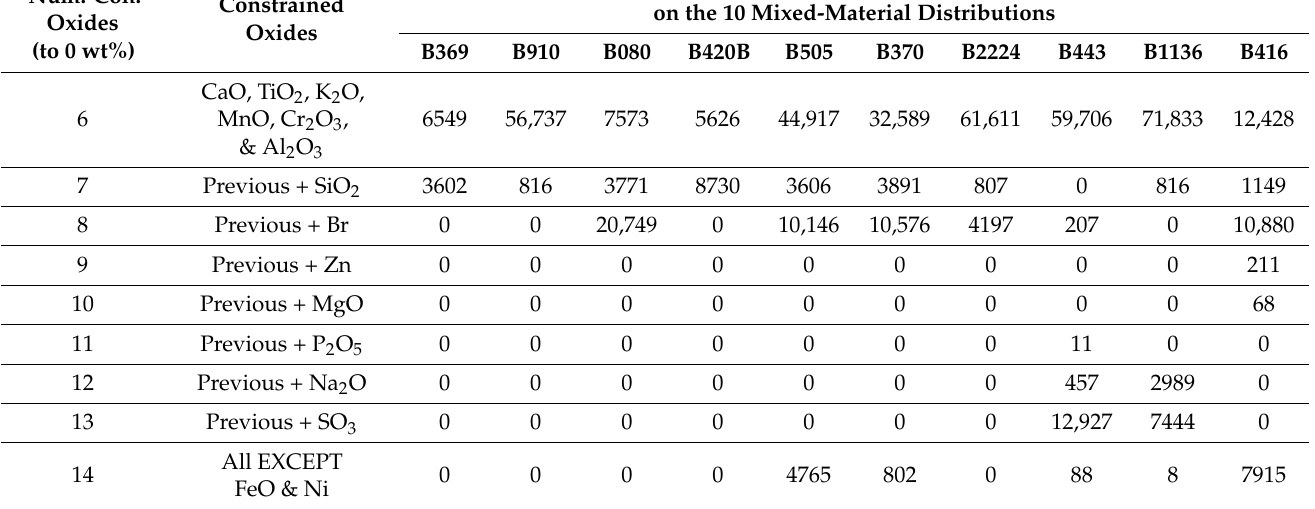
Table 7. Number of complete solution sets to Equation (1) found in sets of 102,816 searches for each of the 10 mixed-material